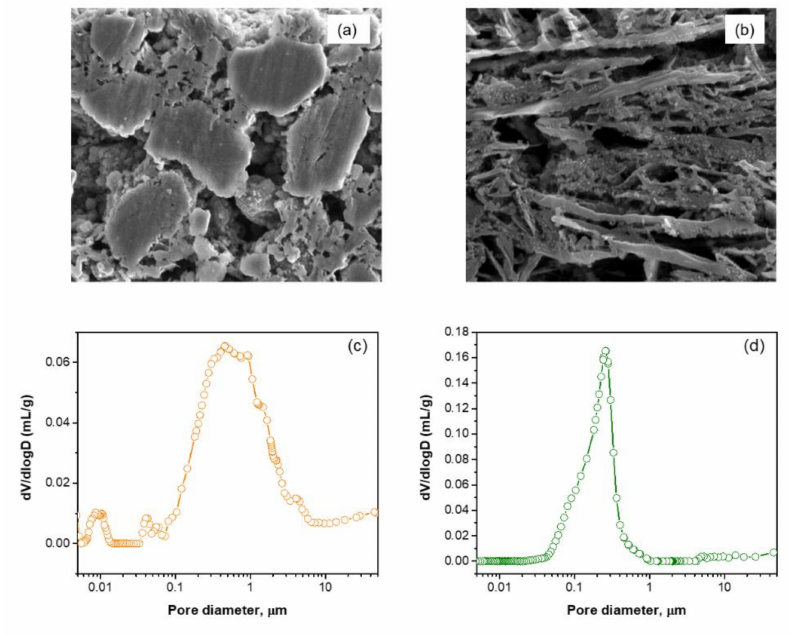
Figure 4. Cross section SEM images of pristine electrodes ( a ) e-BMD and ( b ) e-BMW. Mercury intrusion results of the pristine electrodes ( c ) e-BMD and ( d )